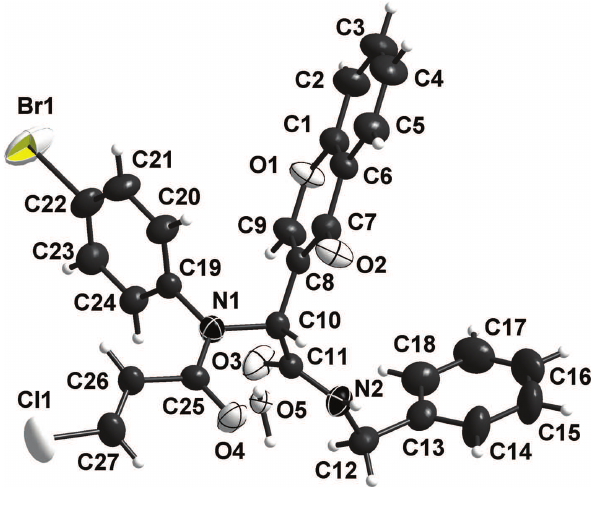
Table 1: Data collection and handling.